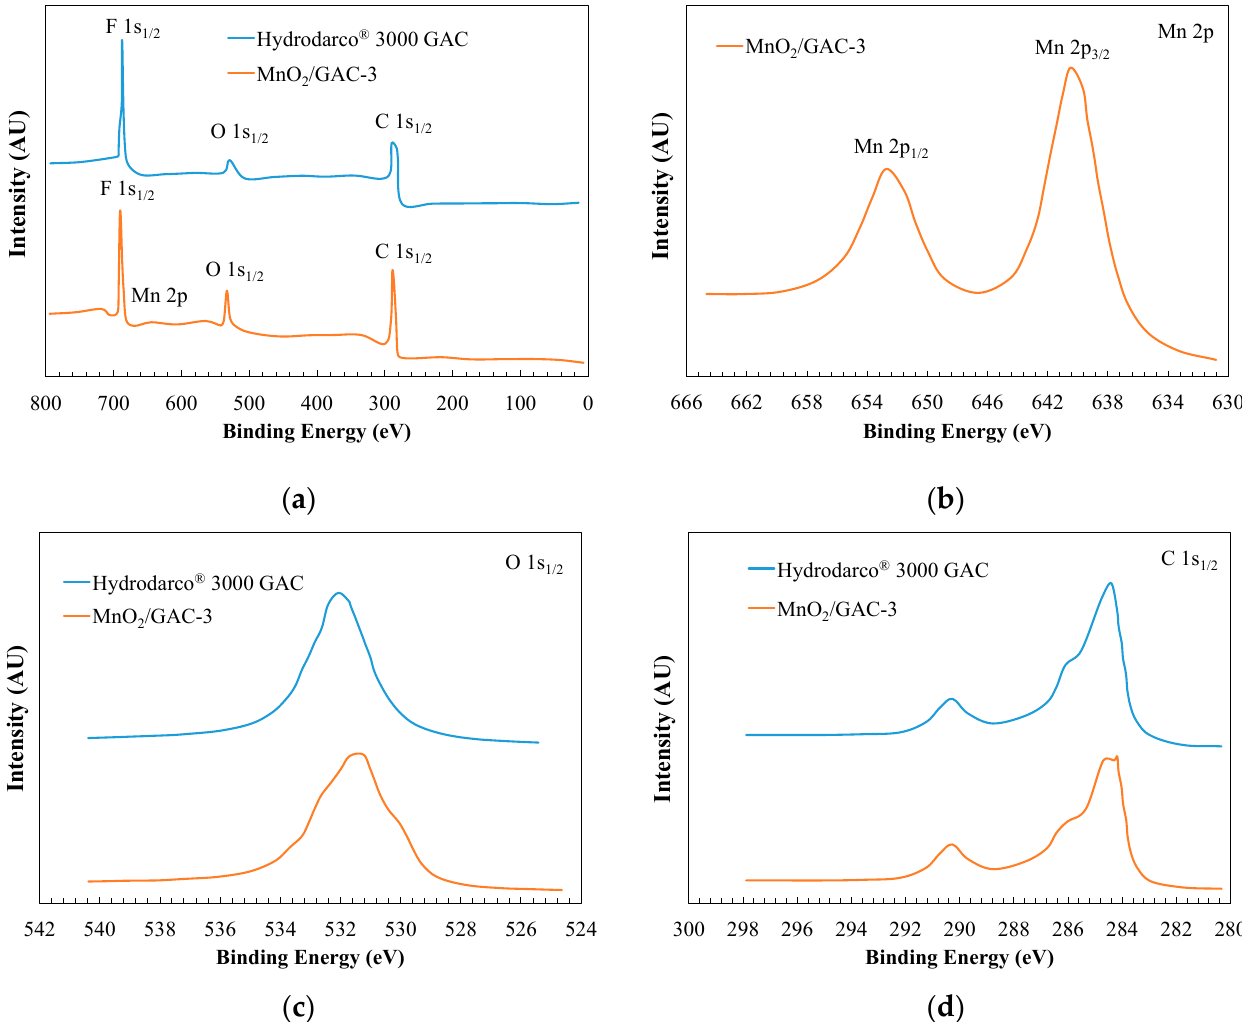
Figure 8. XPS spectra of the GAC Hydrodarco ® 3000 and the MnO 2 /GAC-3 composite ( a ) XPS; and enlarged spectra of the peaks: ( b ) Mn 2p; ( c ) O 1s 1/2 ; ( d ) C 1s 1/2 .